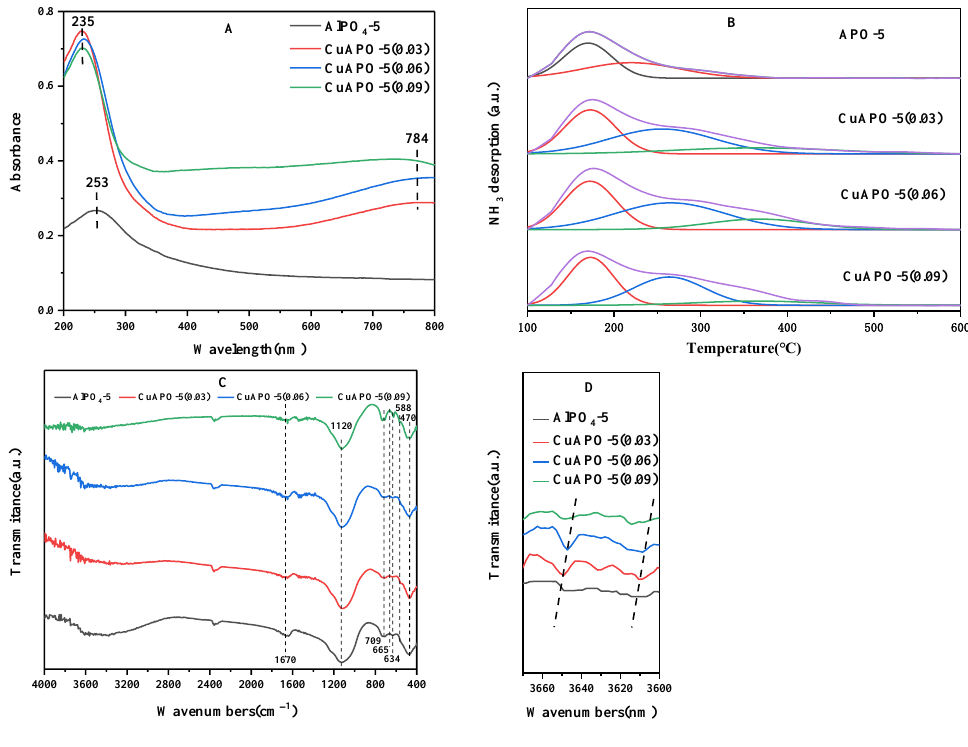
Figure 4. UV-Vis spectra ( A ), NH 3 -TPD curves ( B ), and FTIR spectra ( C , D ) of AlPO 4 -5 and CuAPO-5.